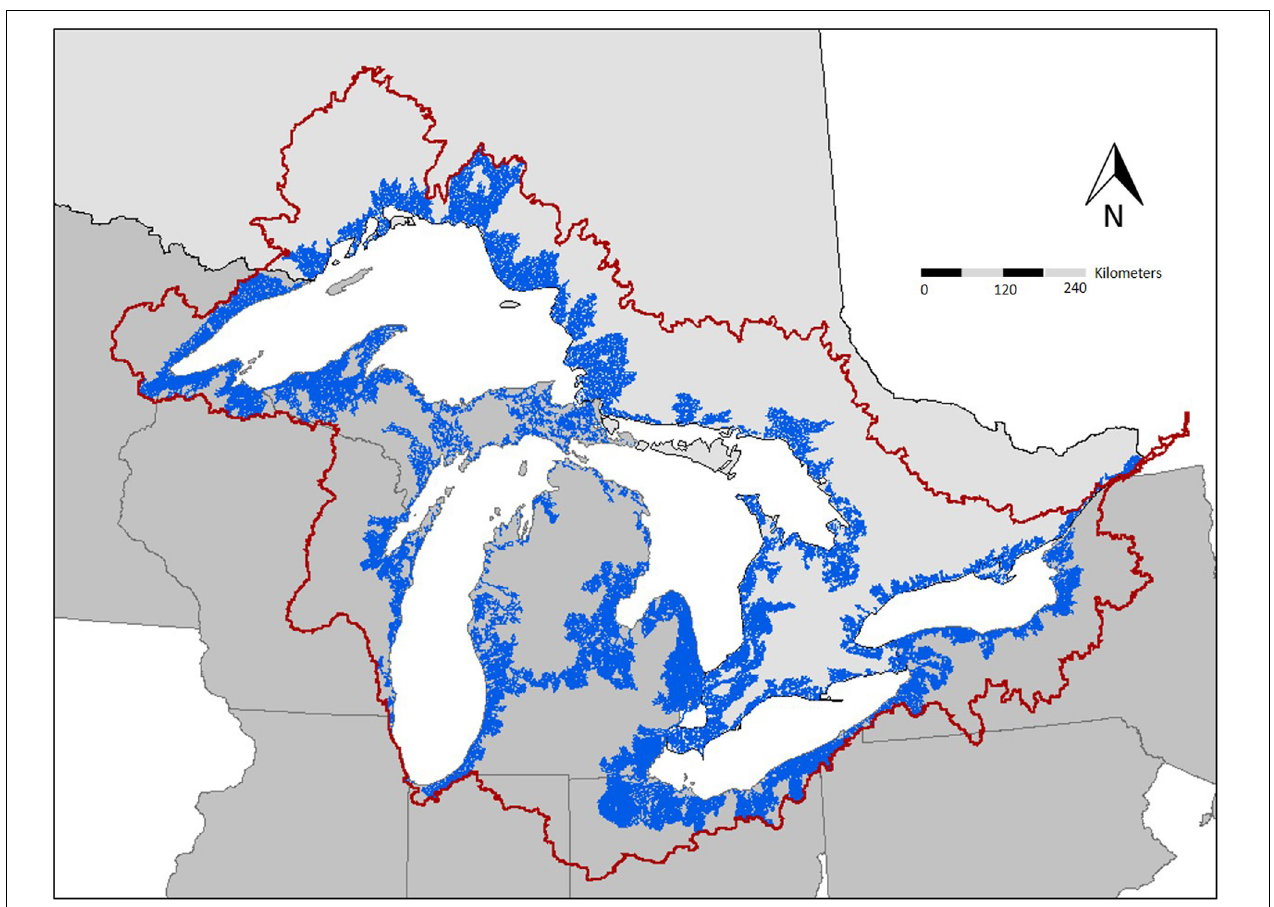
FIGURE 1 | Potential extent of contaminant biotransport in the Great Lakes basin. The dark red line represents the Great Lakes watershed boundary. The blue lines represent tributaries that are accessible to migratory fish. Tributary accessibility data obtained through open source data acquired through Great Lakes aquatic habitat